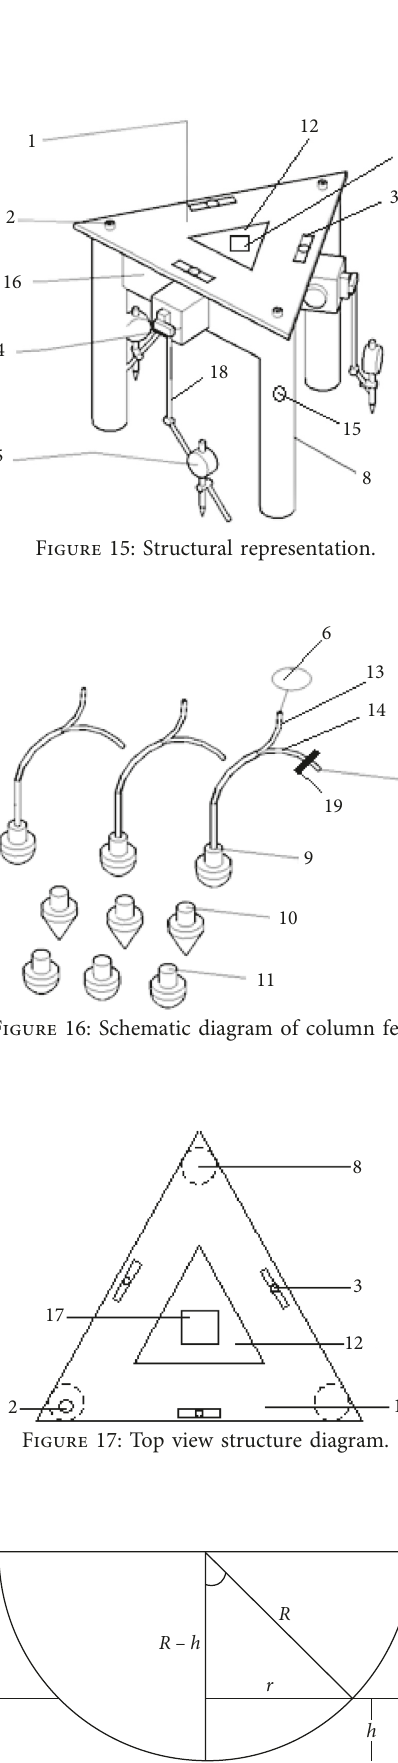
Figure 18: Calculation